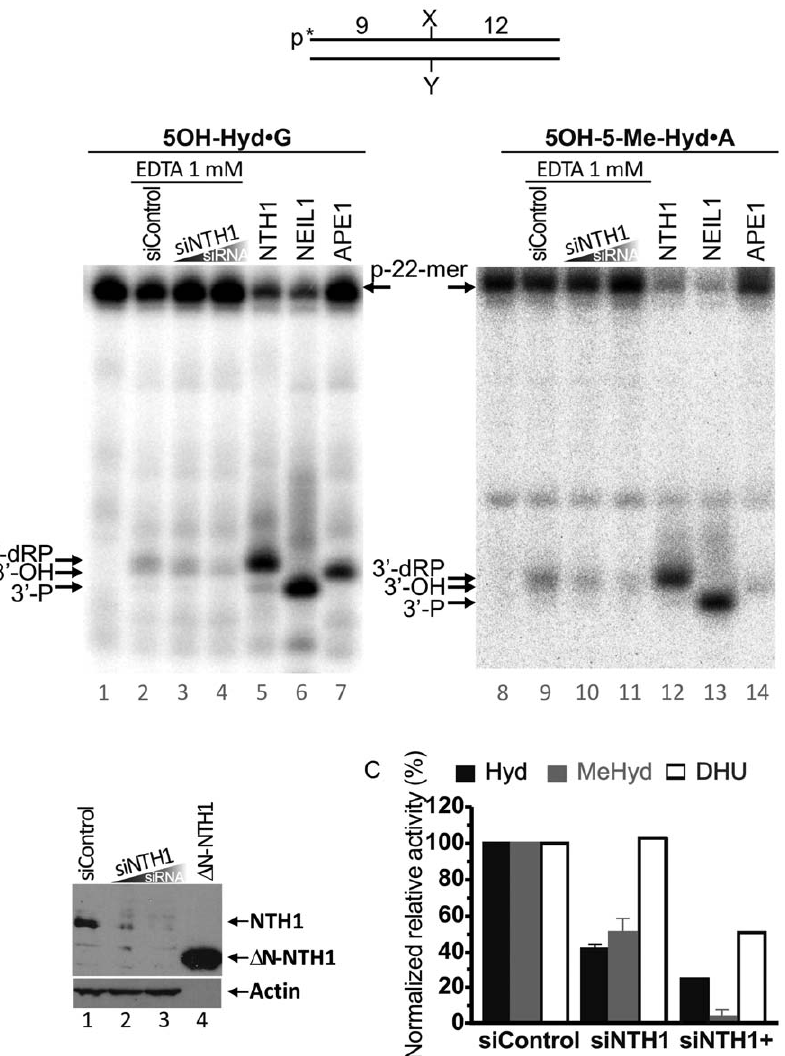
Figure 7. NTH1-catalyzed DNA glycosylase activity towards pyrimidine-derived hydantoins in HeLa cell extracts. 5 9 -[ 32 P]-labelled oligonucleotide duplexes were incubated with HeLa cell extracts under ‘‘BER + EDTA’’ condition. ( A ) Denaturing PAGE analysis of the reaction products. Lane 1, control non-treated 5OH-Hyd N G; lane 2, as 1 but incubated with extract from HeLa cells treated with 400 nM of the non-specific siRNA; lane 3, as 1 but incubated with the extract from HeLa cells treated with 100 nM NTH1-specific siRNA; lane 4, as 3 but using 400 nM of NTH1- specific siRNA; lane 5, as 1 but with 10 nM NTH1; lane 6, as 1 but with 5 nM NEIL1; lane 7, as 1 but with 1 nM APE1; lanes 8–14, same as 1–7 but with 5OH-5Me-Hyd N A as a substrate. ( B ) Western blot analysis of the siRNA-induced down-regulation of NTH1 expression in HeLa cells. Lane 1, control HeLa cells tansfected with 400 nM of the non-specific siRNA; lane 2, HeLa cells tansfected with 100 nM of NTH1-specific siRNA; lane 3, same as 2 but 400 nM siRNA; lane 4, the purified truncated recombinant D N-NTH1 protein. ( C ) Graphic representation of the mean values of DNA repair activities on 5OH-Hyd N G and 5OH-5Me-Hyd N A in extracts. For comparison DNA repair activities on DHU N G substrate were also shown. The cleavage activities in each cell-free extract were normalized to the relative densitometry values of the actin bands on the western blot in panel B. The arrows denote the position of the 9-mer cleavage fragments containing 3 9 -dRP residue (9-dRP), 3 9 -hydroxyl group (3 9 -OH) and 3 9 -phosphate residue (3 9 -P), generated by NTH1, APE1 and NEIL1, respectively. For details see Materials and